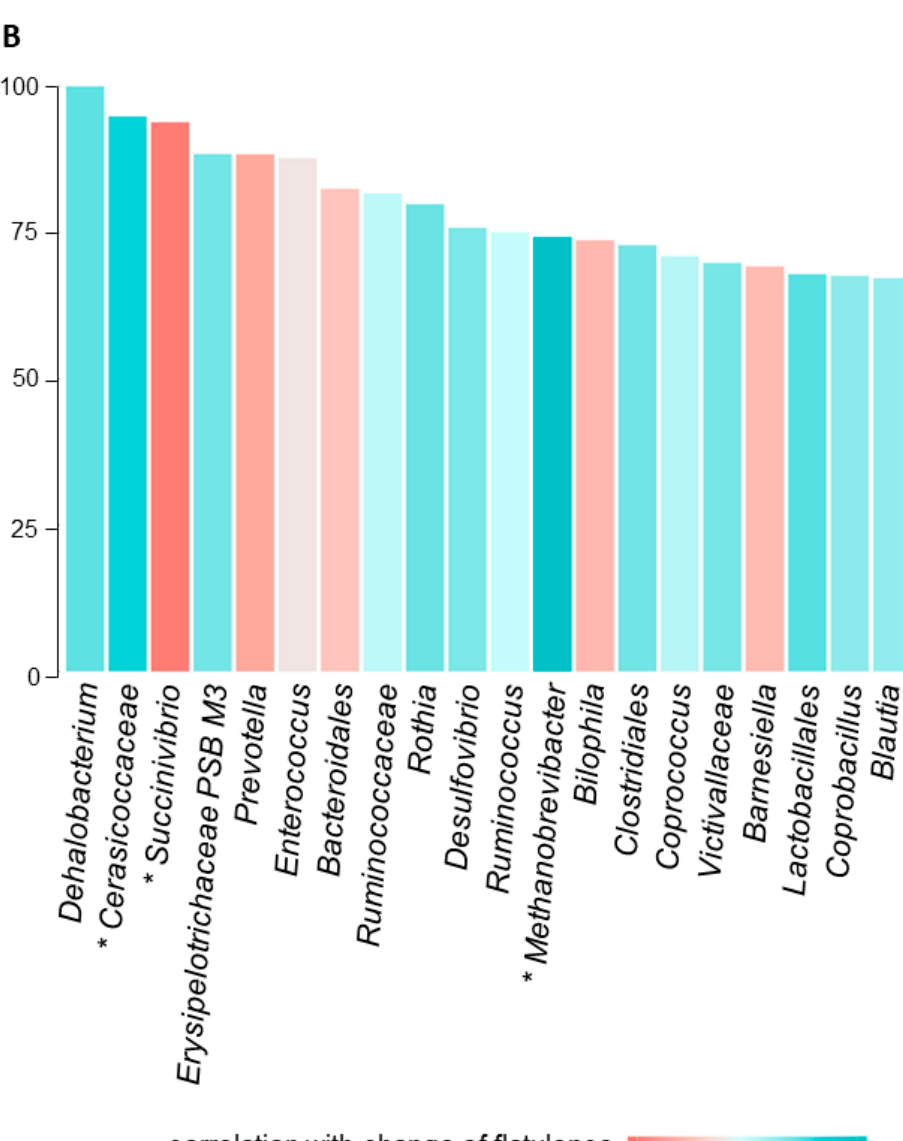
Figure 4. Random forest relative variable importance of most relevant microbiota genera associated with change in clinical parameters upon fermented milk product (FMP) consumption. Top 20 most important variables from random forest to predict changes between study conditions “flatulogenic diet” and “flatulogenic diet + FMP” of ( A ) anal gas (number of anal gas evacuations) and ( B ) flatulence. Strength and significance of Spearman correlations (rho coefficient) are indicated in the color shade. Red: change in microbiota genera negatively associated with the change in clinical parameter. Blue: change in microbiota genera positively associated with the change in clinical parameter. * ( p < 0.05).